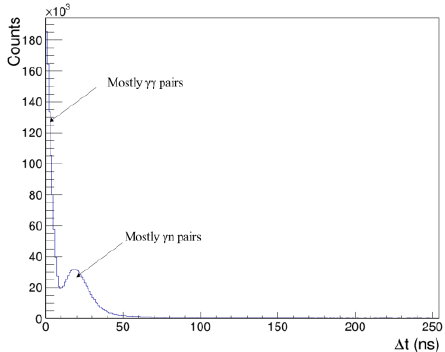
Fig. 2. Rossi-Alpha distribution obtained for the measurement in presence of the 252 Cf source